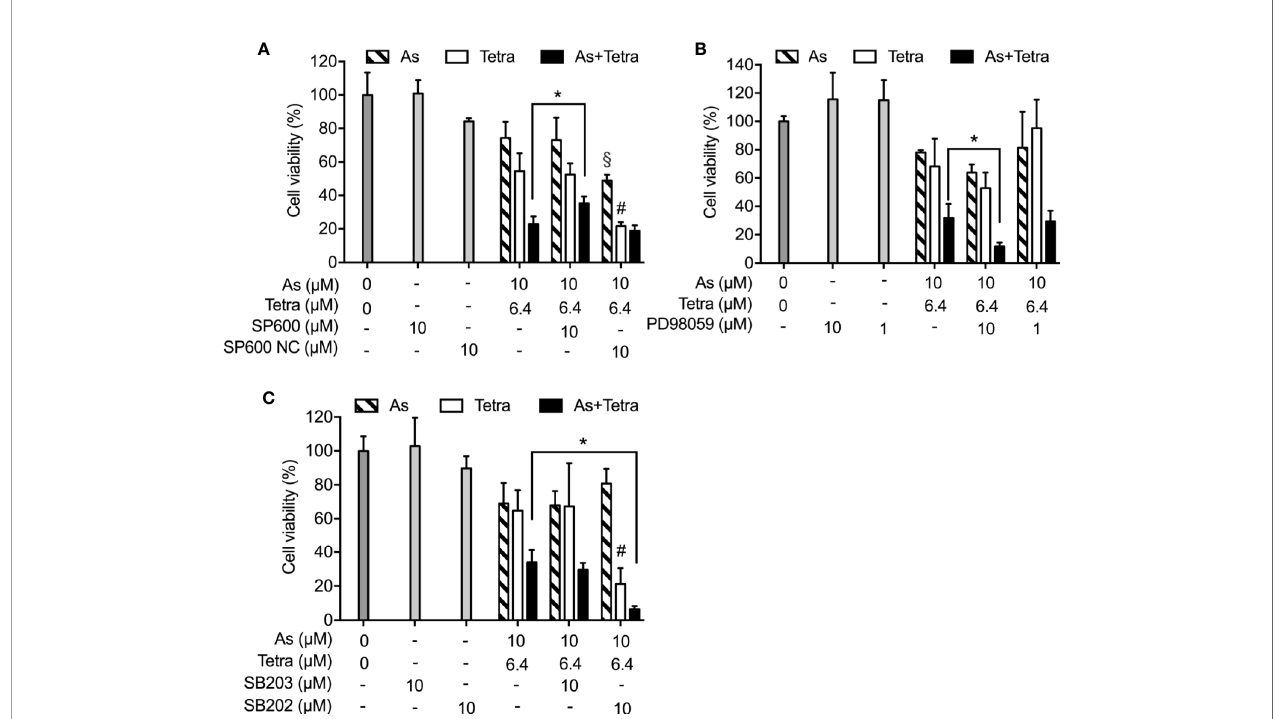
FIGURE 7 | Abrogation of the cytotoxicity of As III combined with Tetra by JNK inhibition in MDA-MB-231 cells. Following the treatment for 48 h with 10 m M As III and 6.4 m M Tetra, alone or in combination, in the presence or absence of MAPK inhibitors and their negative controls [JNK inhibitor SP600125 and its negative control SP600125NC (A) ; ERK inhibitor PD98059 (B) ; p38 MAPK inhibitor SB203580 and its negative control SB202474 (C) ], the cell viability of MDA-MB-231 was determined by XTT assay. Relative cell viability was calculated as the ratio of the absorbance at 450 nm of each treatment group against those of the corresponding untreated control group. Data are shown as the means and SD from more than three independent experiments. *p<0.01 vs. the combination; § p<0.01, vs. 10 m M As III alone; # p<0.01, vs. 6.4 m M Tetra alone. As, As III ; Tetra, tetrandrine; SP600, SP600125; SP600 NC, SP600125NC; SB203, SB203580; SB202,